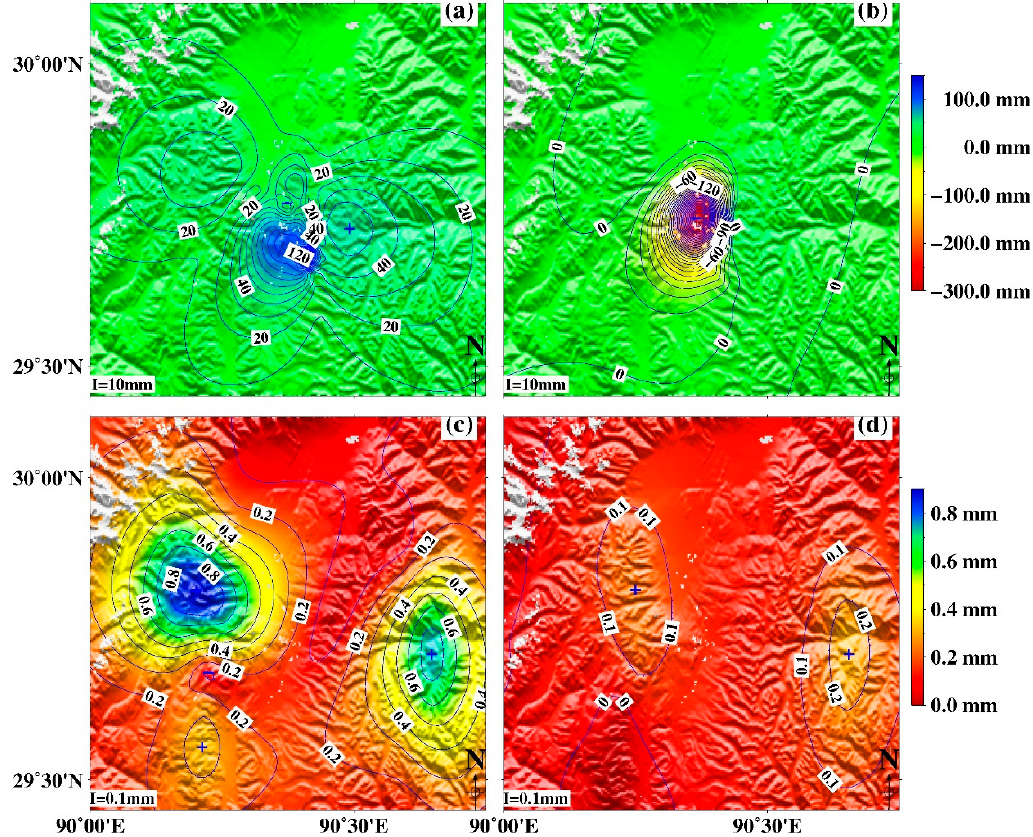
Figure 6. Contour maps of coseismic surface displacements and differences between the flat free surface model and the topographic relief model. The contour interval is shown at the bottom left corner. ( a ) Horizontal coseismic surface displacements estimated from the model with topographic relief; ( b ) Differences between horizontal displacements of the model with flat free surface and the model with topographic relief; ( c ) Vertical coseismic surface displacements estimated from the model with topographic relief; ( d ) Differences between vertical displacements of the model with flat free surface and the model with topographic